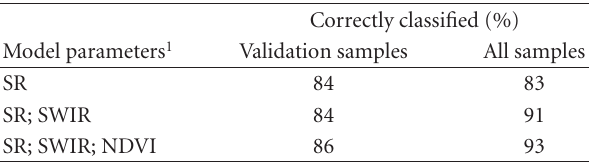
Table 6: Classification results (%age of individual trees that were correctly classified as infested or not infested with the adelgid) obtained from the discriminant analysis procedure for the SPOT5-HRVIR Band Equivalent Reflectance (BER). Results in the validation samples column were generated by applying the discriminant function developed from a randomly selected training data set to the remaining 33% of the observations ( n = 68). Results in the all samples column were generated by applying the discriminant function developed using the entire data set of 206 trees sampled during the